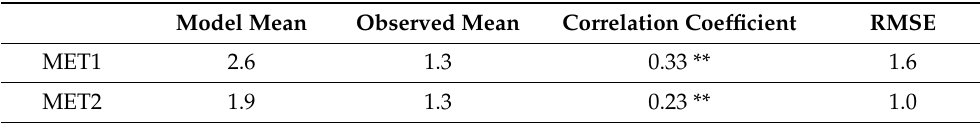
Table 4. Statistical analysis of 10 m wind speed simulation results (unit: m s − 1 ). Model Mean Observed Mean Correlation Coefficient RMSE